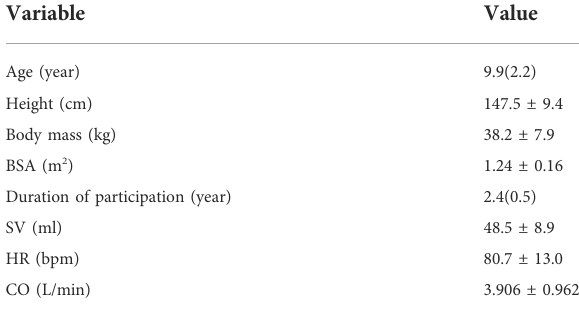
TABLE 1 Demographic characteristics of the athletes.